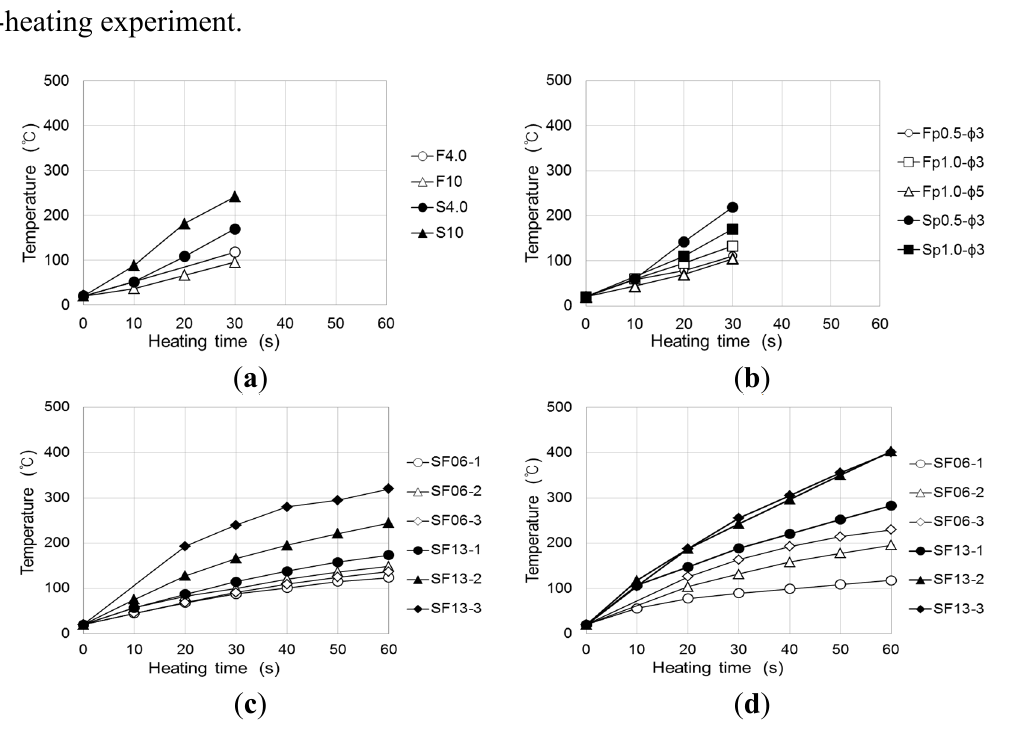
Figure 19. Temperature elevation characteristics of induction heating of adhered mortar to which conductive resistor is mixed. ( a ) Metal mesh (2.25 kW); ( b ) punching metal (2.25 kW); ( c ) steel fiber (2.25 kW); ( d ) steel fiber (4.0